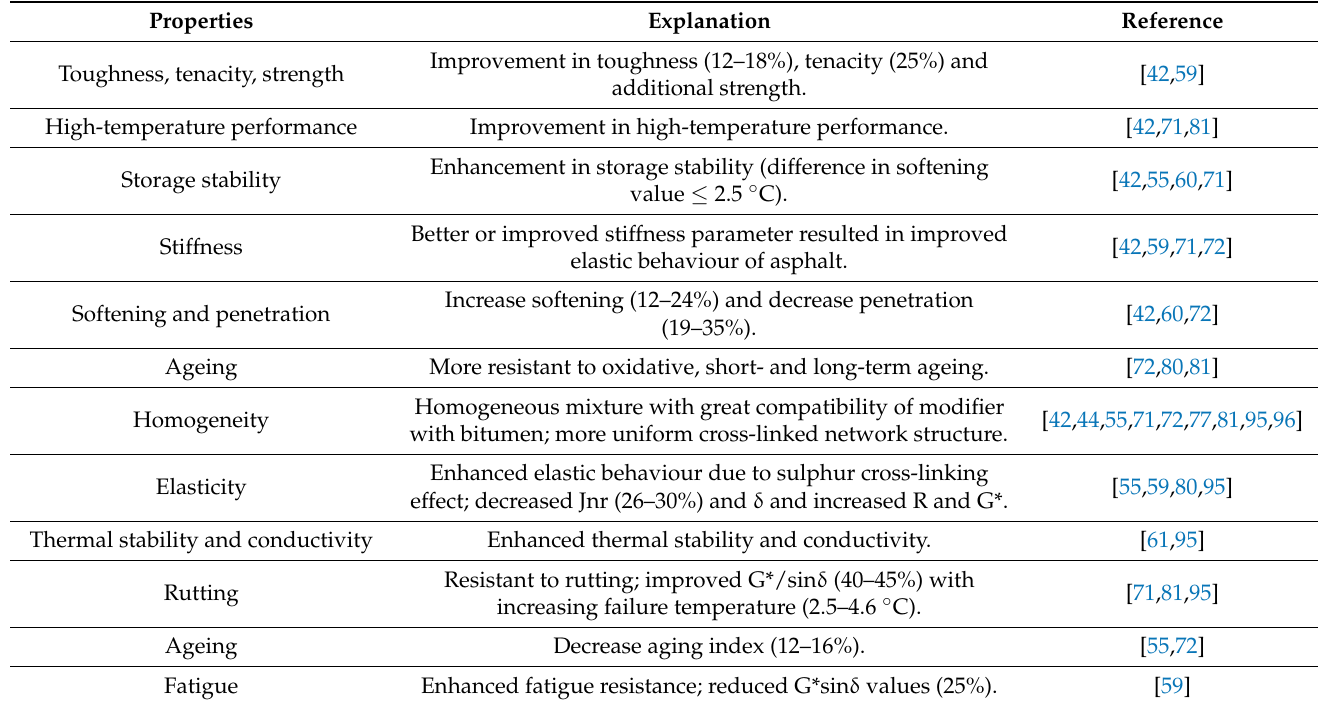
Table 22. Significant properties of sulphur